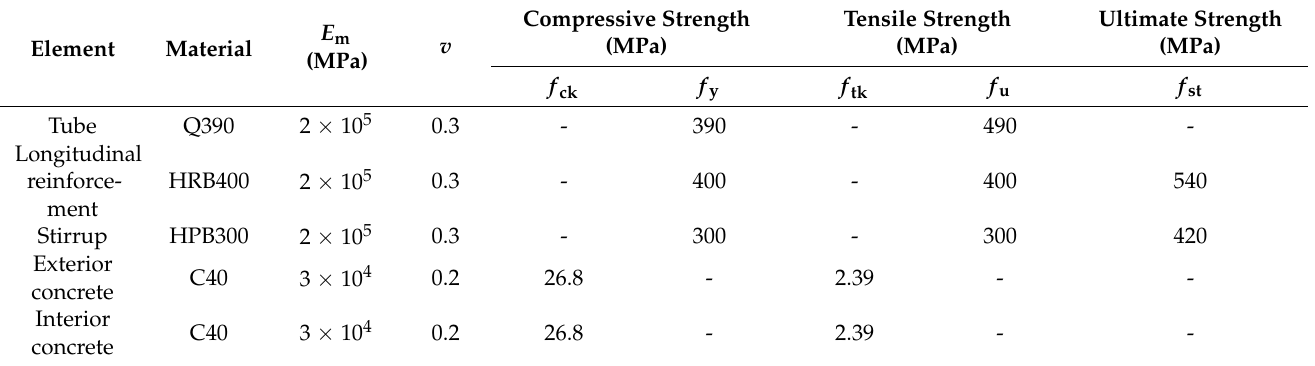
Table 2. Mechanical properties of the materials.